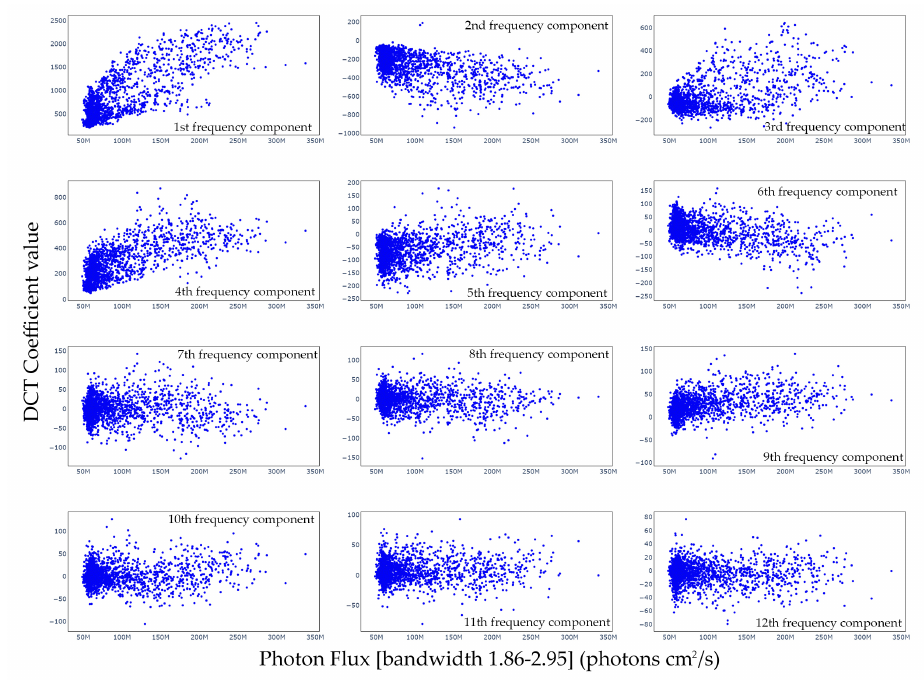
Figure 5. Amplitude of TEC frequency components versus Photon Flux at 1.86–2.95 nm